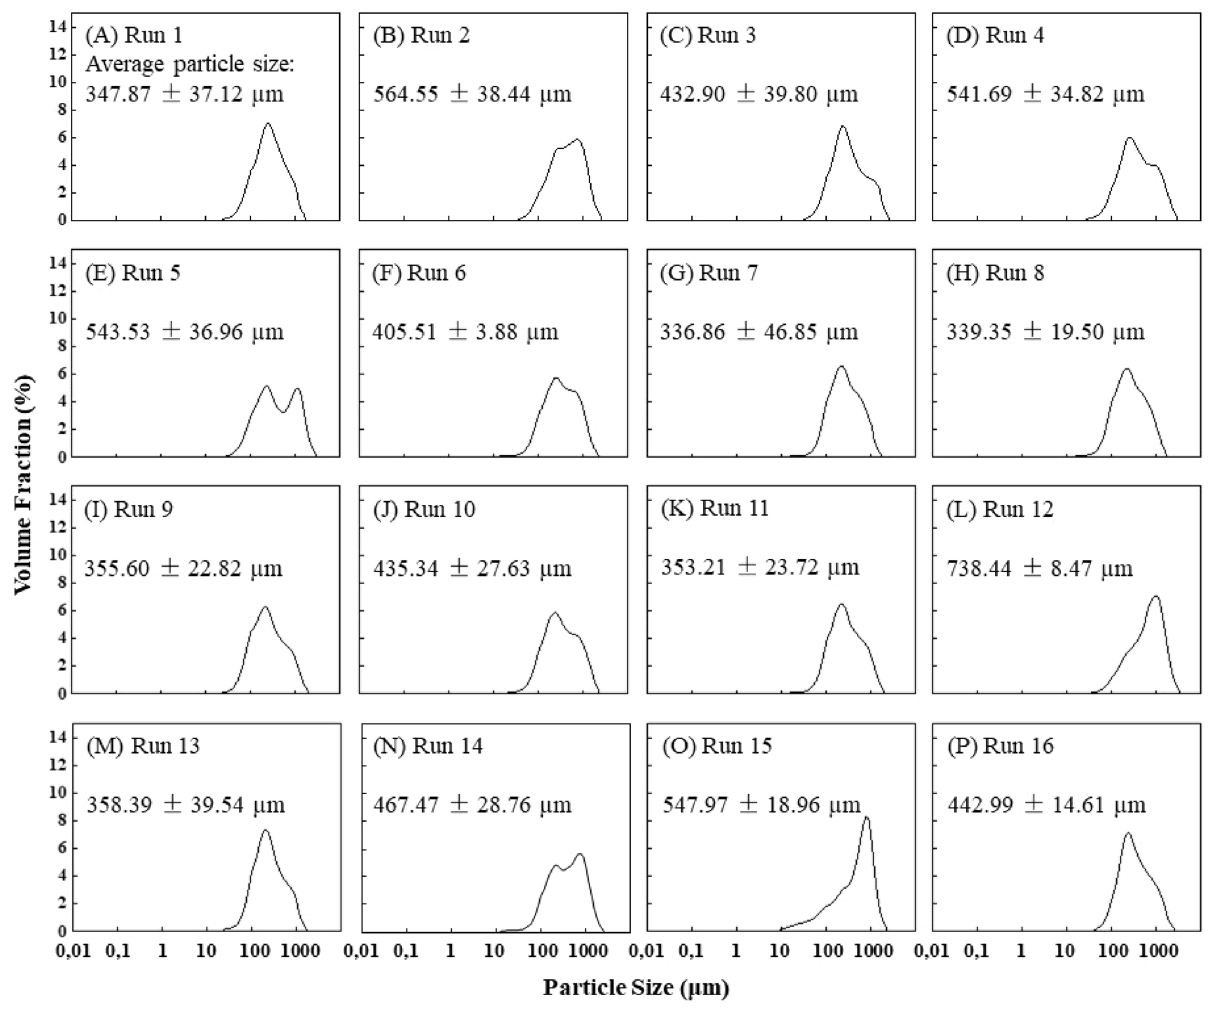
Figure 2. The powder particle size of the run parameters: ( A ) Run 1; ( B ) Run 2; ( C ) Run 3; ( D ) Run 4; ( E ) Run 5; ( F ) Run 6; ( G ) Run 7; ( H ) Run 8; ( I ) Run 9; ( J ) Run 10; ( K ) Run 11; ( L ) Run 12; ( M ) Run 12; ( N ) Run 14; ( O ) Run 15; ( P ) Run